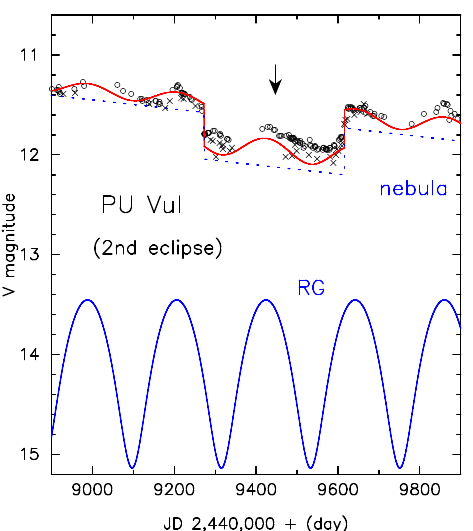
Fig. 5. A close-up view of the second eclipse. Observational data are taken from Kolotilov et al. (1995) (crosses) and Yoon & Honeycutt (2000) (open circles). The upper solid line (red) indicates the composite light curve which is the sum of the pulsating RG (lower solid line, blue) and of the nebula emission (dotted line). The RG pulsates with the amplitude of 65 % around its equilibrium luminosity corresponding to m V = 13 : 8. The downward arrow indicates the date of mid-eclipse, JD 2 449 447.